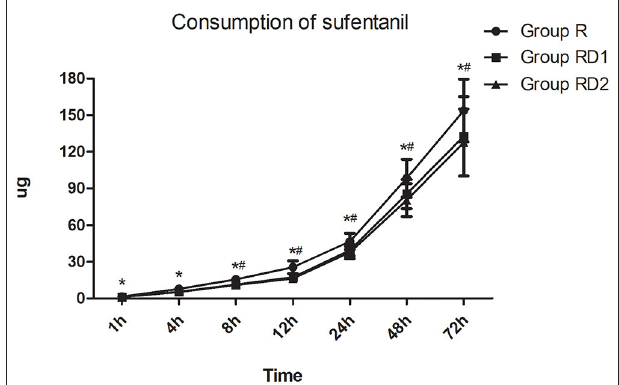
FIGURE 4 | Post-operative sufentanil requirement during the first 72h after surgery among the three groups. * P < 0.05 vs. group R, # P < 0.05 vs. group